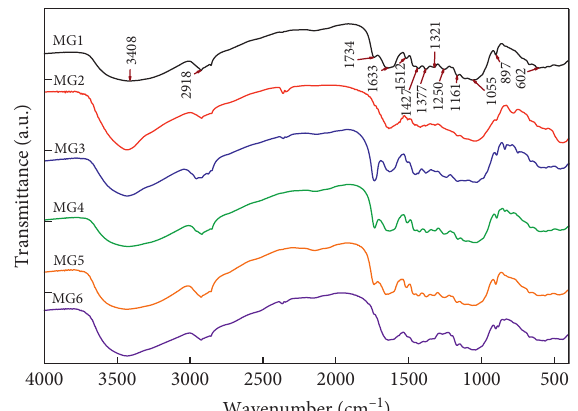
Figure 5: FTIR spectrogram of wheat straw fibers before and after